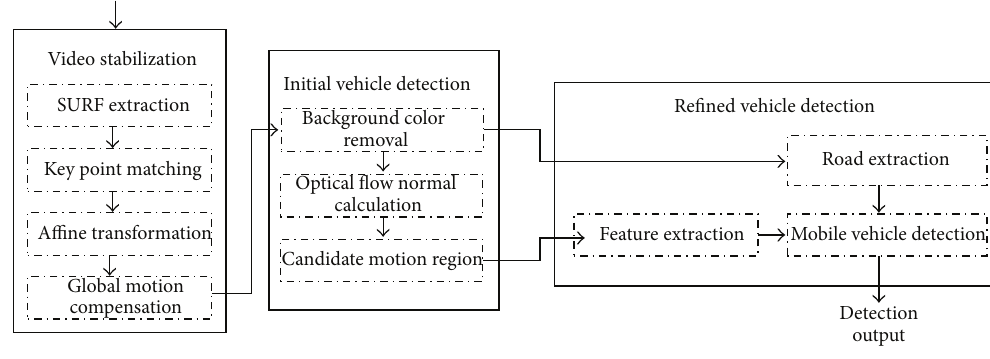
Figure 1: Overview of the proposed method.